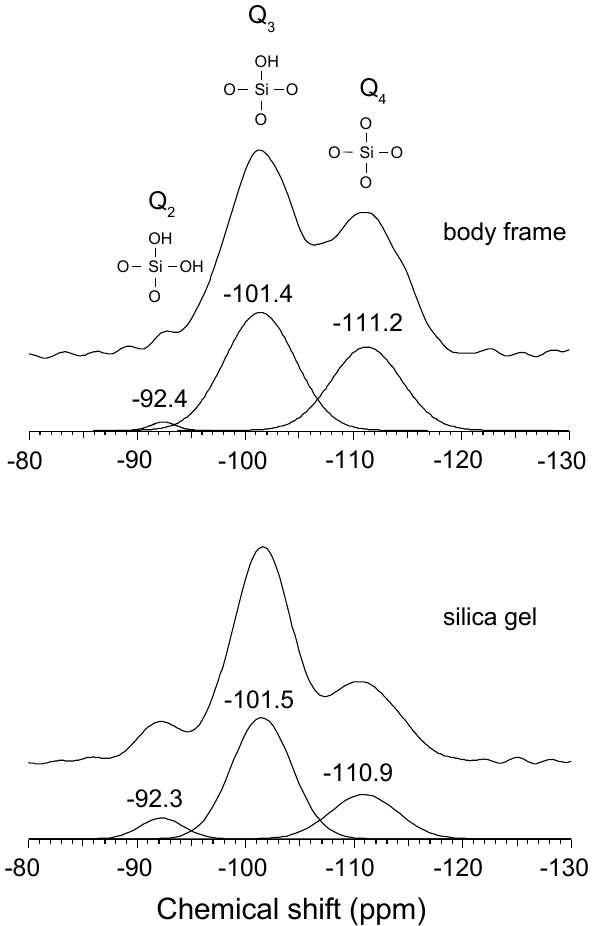
Figure 5. CP-MAS NMR spectra for sponge body frame and silica gel.